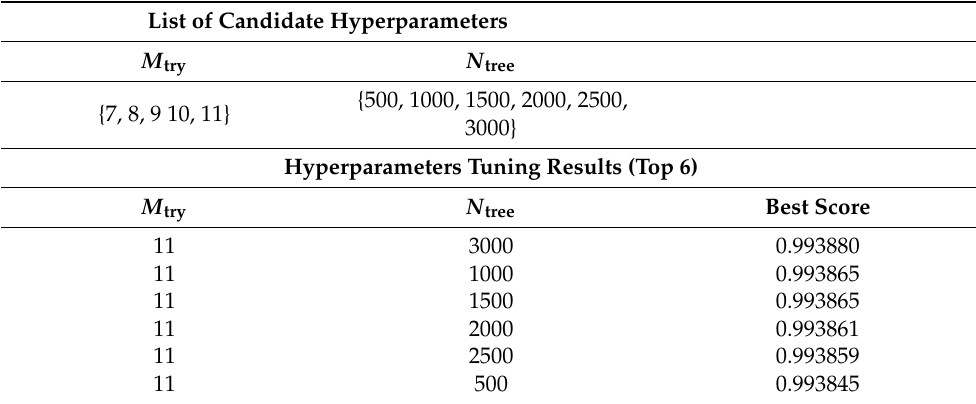
Table A4. The list of candidate parameters and parameters tuning results for finding the optimal parameter set in